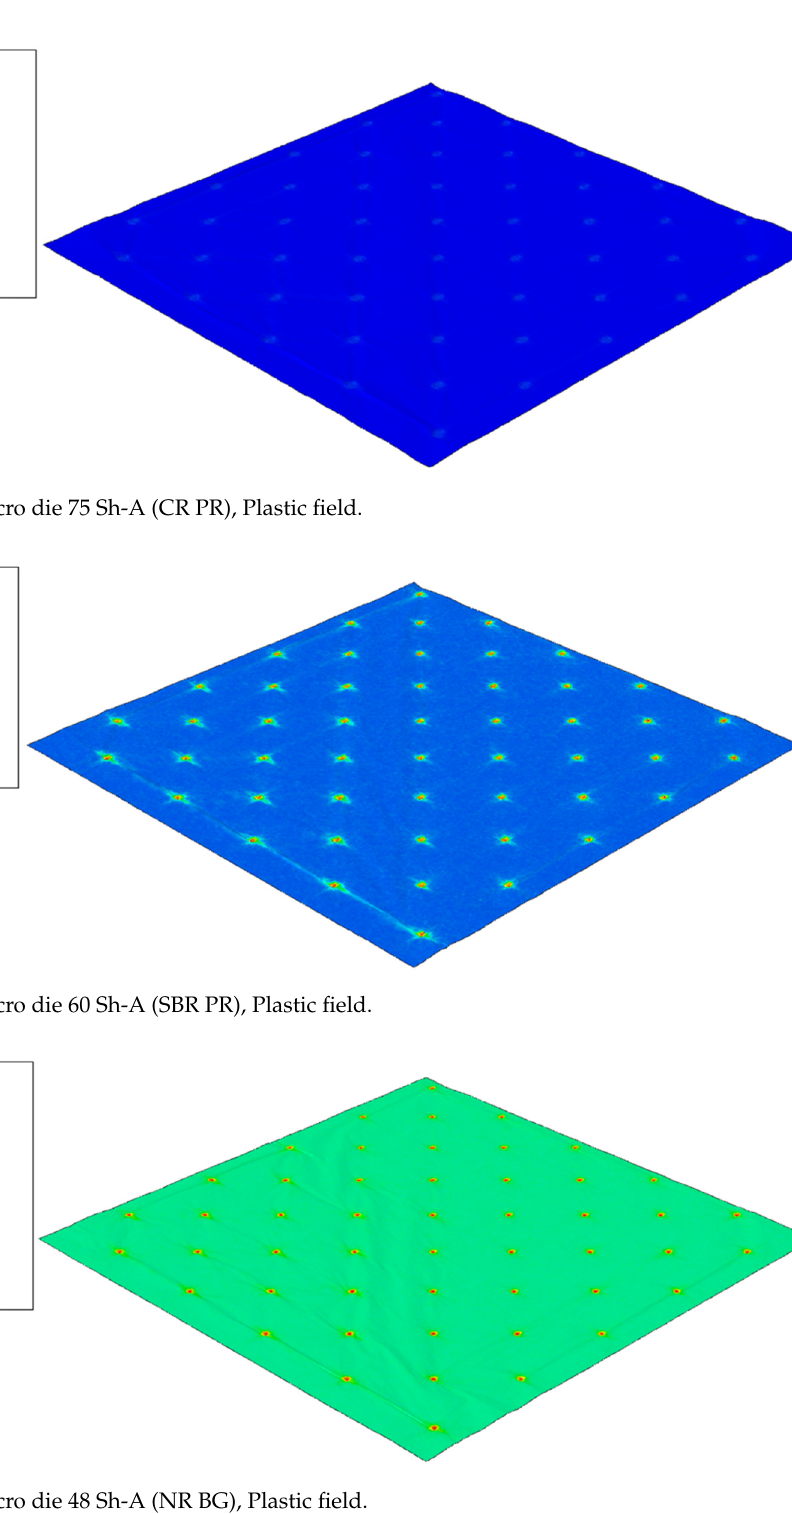
Figure 22. Micro die 48 Sh-A (NR BG), Plastic field.